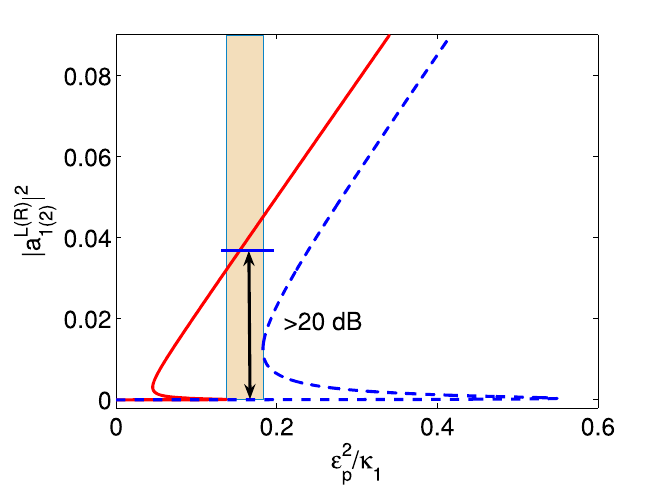
2 (blue dashed line) 1